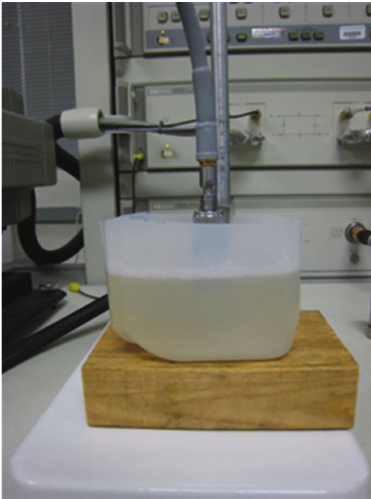
Figure 7: Experimental setup for measuring permittivity of tissue- equivalent liquid.